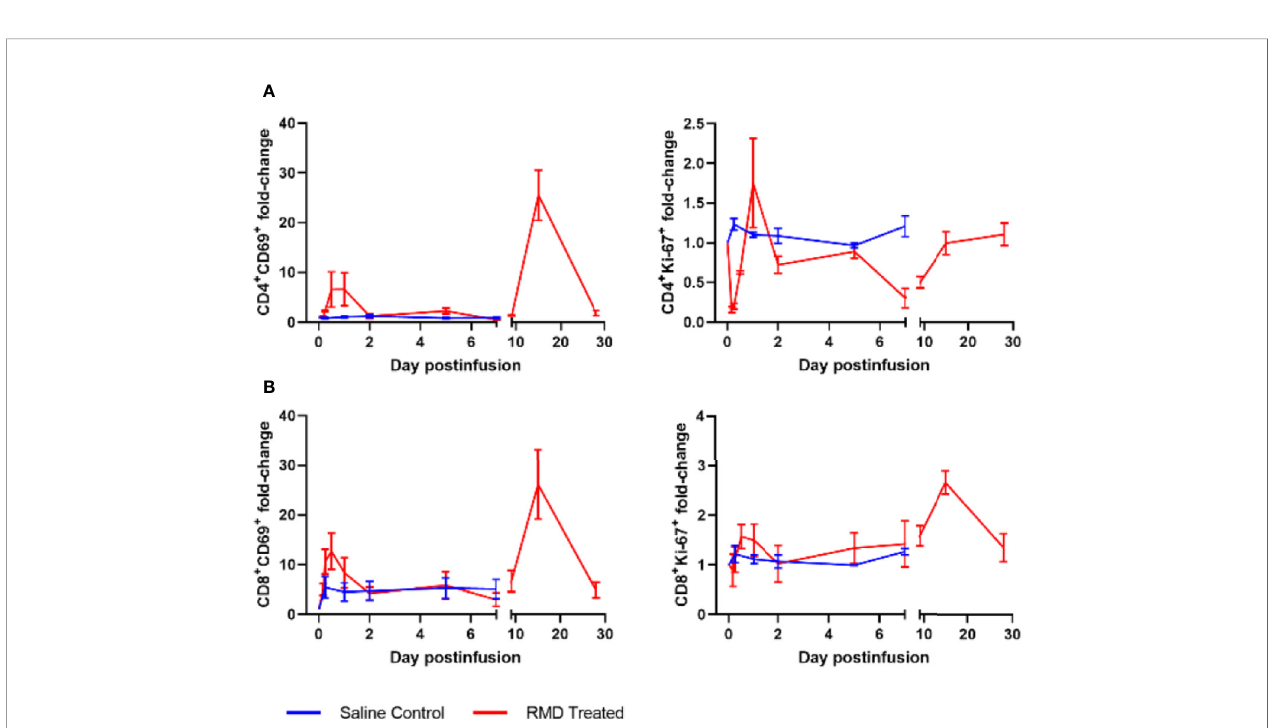
FIGURE 7 | Lymphocyte activation with RMD treatment. Whole blood was stained for (A) CD4 + and (B) CD8 + lymphocyte markers: CD69 and Ki-67; animal number, n = 3 per